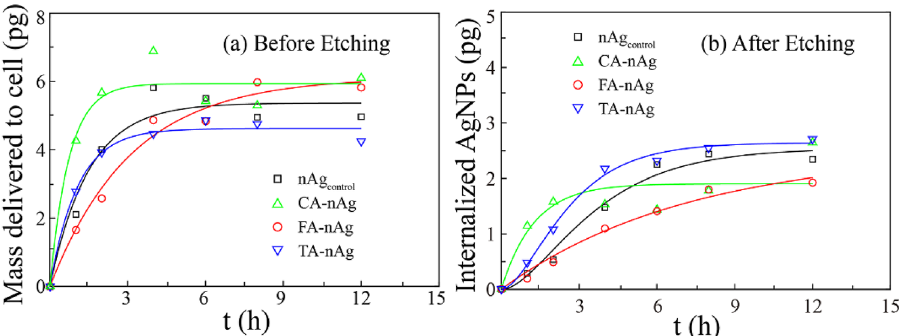
Figure 3. The internalization of AgNPs into A549 cell over 12 h after exposure with 10 μg ml −1 nAg control , CA-nAg, FA-nAg and TA-nAg in CM. ( a ) Cellular mass of AgNPs in A549 cell ( M d , pg) and ( b ) Mass of AgNPs internalized to A549 cell ( M